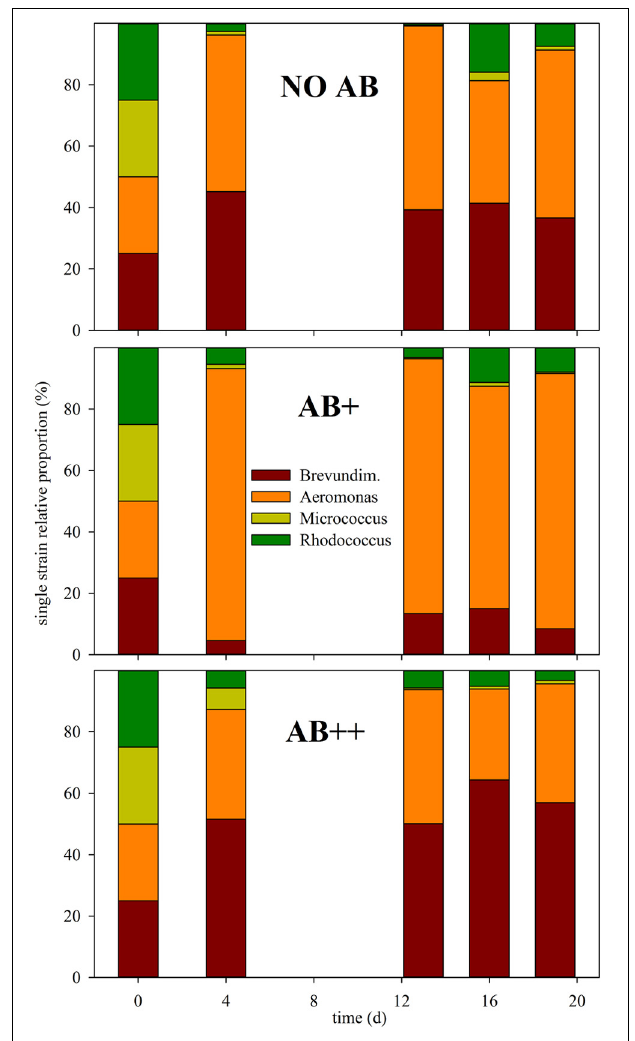
FIGURE 3 | Relative proportion of each strain in continuous culture vs. time. The relative proportion of each strain is given as mean of three replicates at day (d) 0, 4, 13, 16, and 20, for each of the three treatments (from top to bottom): NO AB, AB + , AB ++ .